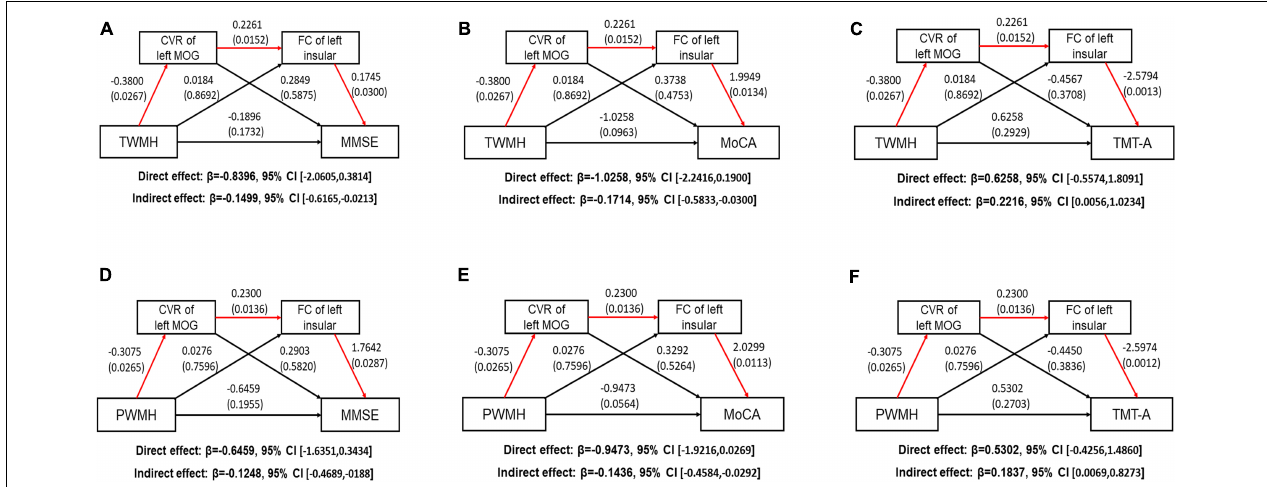
FIGURE 5 | Path models show the direct and indirect relationships between white matter hyperintensity volume and cognitive function. The significant pathways are highlighted in red lines. For each connection, the standard coefficient and P -value are shown. The direct and indirect effect and their 95% CI are also shown. (A) TWMH volume was indirectly associated with poorer MMSE score through aberrant CVR of left MOG and FC of left insula-MOG (Indirect effect: − 0.1499, 95% CI [ − 0.6165, − 0.0213]. (B) TWMH volume was indirectly associated with poorer MoCA score through aberrant CVR of left MOG and FC of left insula-MOG (Indirect effect: − 0.1714, 95% CI [ − 0.5833, − 0.0300]. (C) TWMH volume was indirectly associated with longer TMT-A time through aberrant CVR of left MOG and FC of left insula-MOG (Indirect effect: − 0.2218, 95% CI [0.0056, 1.0234]. (D) PWMH volume was indirectly associated with poorer MMSE score through aberrant CVR of left MOG and FC of left insula-MOG (Indirect effect: − 0.1248, 95% CI [ − 0.4689, − 0.0188]. (E) PWMH volume was indirectly associated with poorer MoCA score through aberrant CVR of left MOG and FC of left insula-MOG (Indirect effect: − 0.1436, 95% CI [ − 0.4584, − 0.0292]. (F) PWMH volume was indirectly associated with longer TMT-A time through aberrant CVR of left MOG and FC of left insula-MOG (Indirect effect: 0.1837, 95% CI [0.0069, 0.8273]. CI, confidence interval; CVR, cerebrovascular reactivity; FC, functional connectivity; MOG, middle occipital gyrus; TWMH, total white matter hyperintensity; MMSE, Mini-Mental State Examination; MoCA, Montreal Cognitive Assessment; TMT, Trail Making Test; PWMH, periventricular white matter